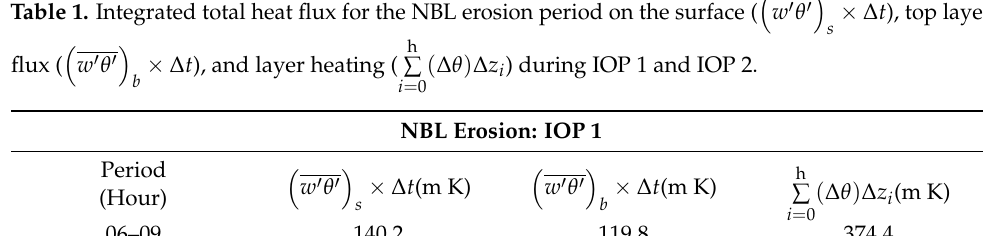
(cid:16) (cid:17) × ∆ t ), top layer w (cid:48) θ (cid:48) s